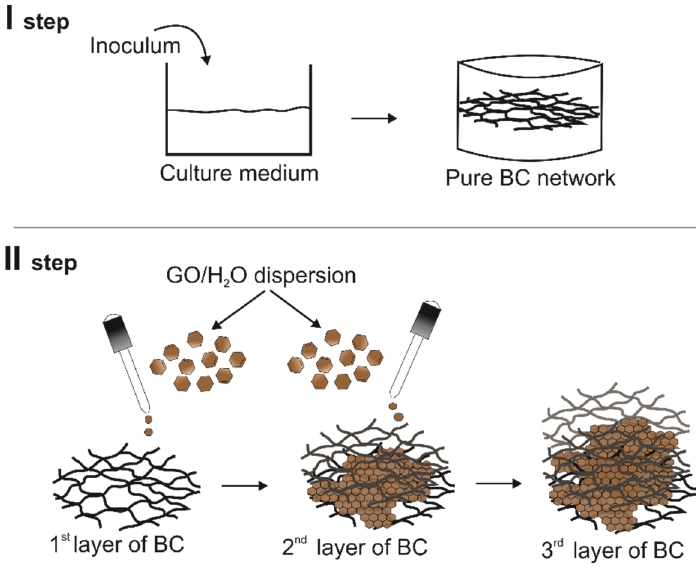
Figure 2. The loading process of GO/H 2 O application onto the BC network surface [45].